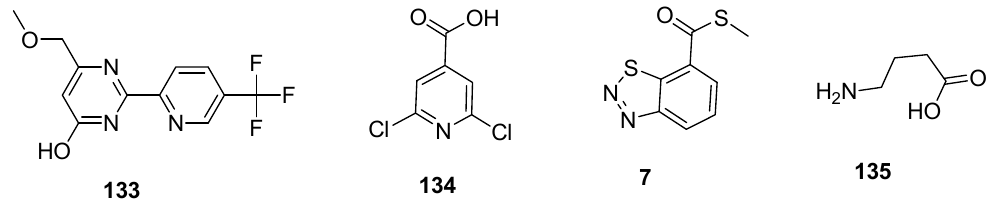
Figure 24. Structures of commercially available plant activators 133–135 .